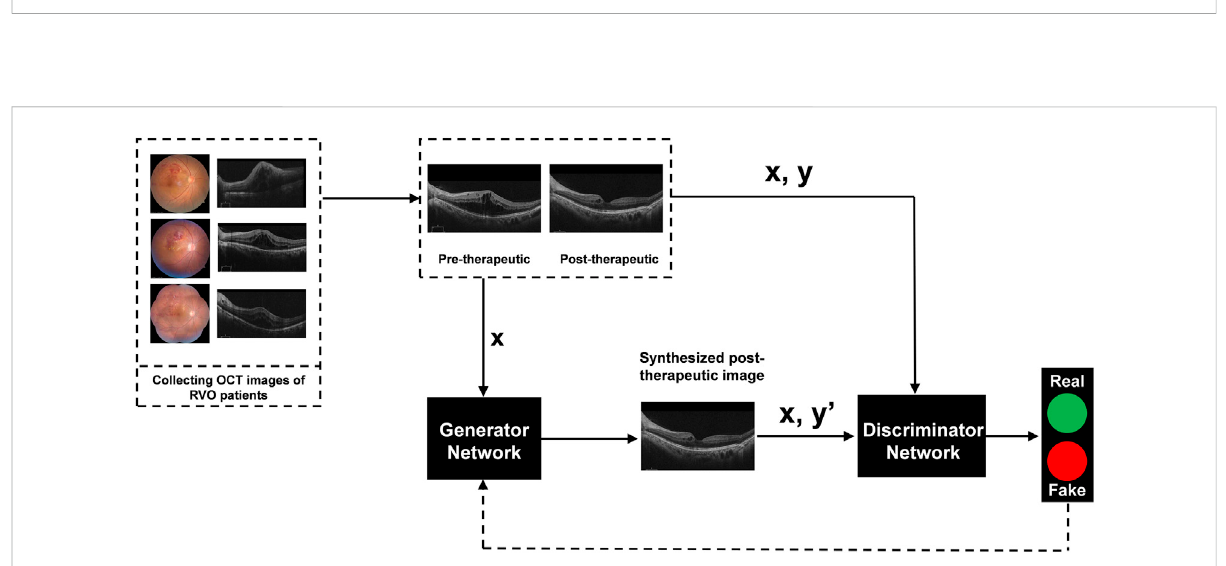
FIGURE 2 Illustrationofgenerating post-therapeuticOCTfrompre-therapeuticOCTbytheGAN-basedalgorithm. OCT,opticalcoherencetomography; GAN, generative adversarial networks; RVO, retinal vein